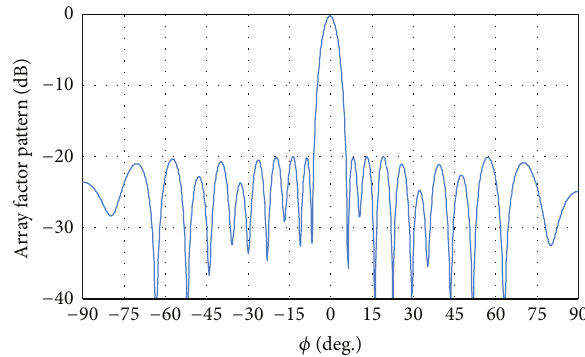
Figure 3: The synthesized radiation pattern with optimally minimal array elements (14 elements) under complex weight coefficient